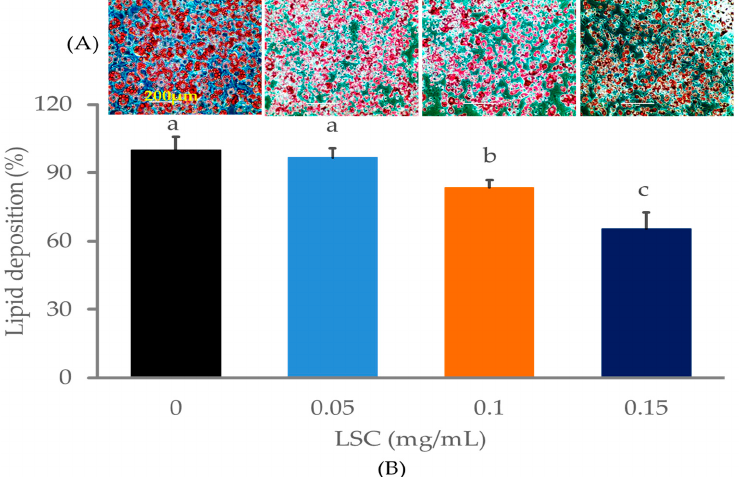
Figure 2. Impact of LSC on fat deposition in adipocytes on day 10. Cells were seeded in a 6-well culture plate at the density of 3 × 10 4 /well and incubated at 37 ◦ C with 5% CO 2 . Differentiation was induced by differentiation cocktails (insulin, DEX and IBMX) for 48 h. The cells were then switched to insulin medium for another 48 h. LSC at different concentrations was used to treat cells when differentiation was initiated. ORO staining was performed to stain lipid depositions in differentiated cells. ( A ) Oil red O-stained cells (200 µ m) were then observed using an Evos microscope (20 × /20 × magnifications). ( B ) Percentage of fat depositions in experimental adipocytes. Data are presented as mean ± standard deviation ( n = 5). Different alphabets within the figure indicate significant differences at p < 0.05 level.